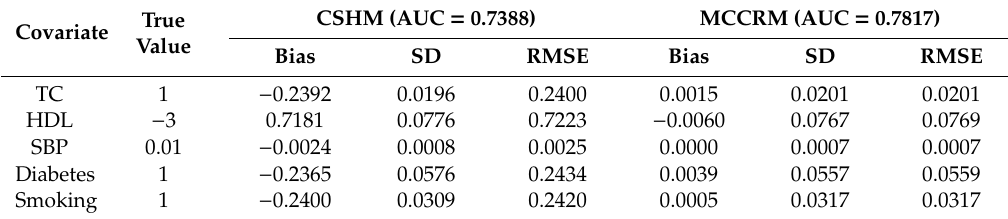
Table 2. Comparisons of the coe ffi cients of the two models.